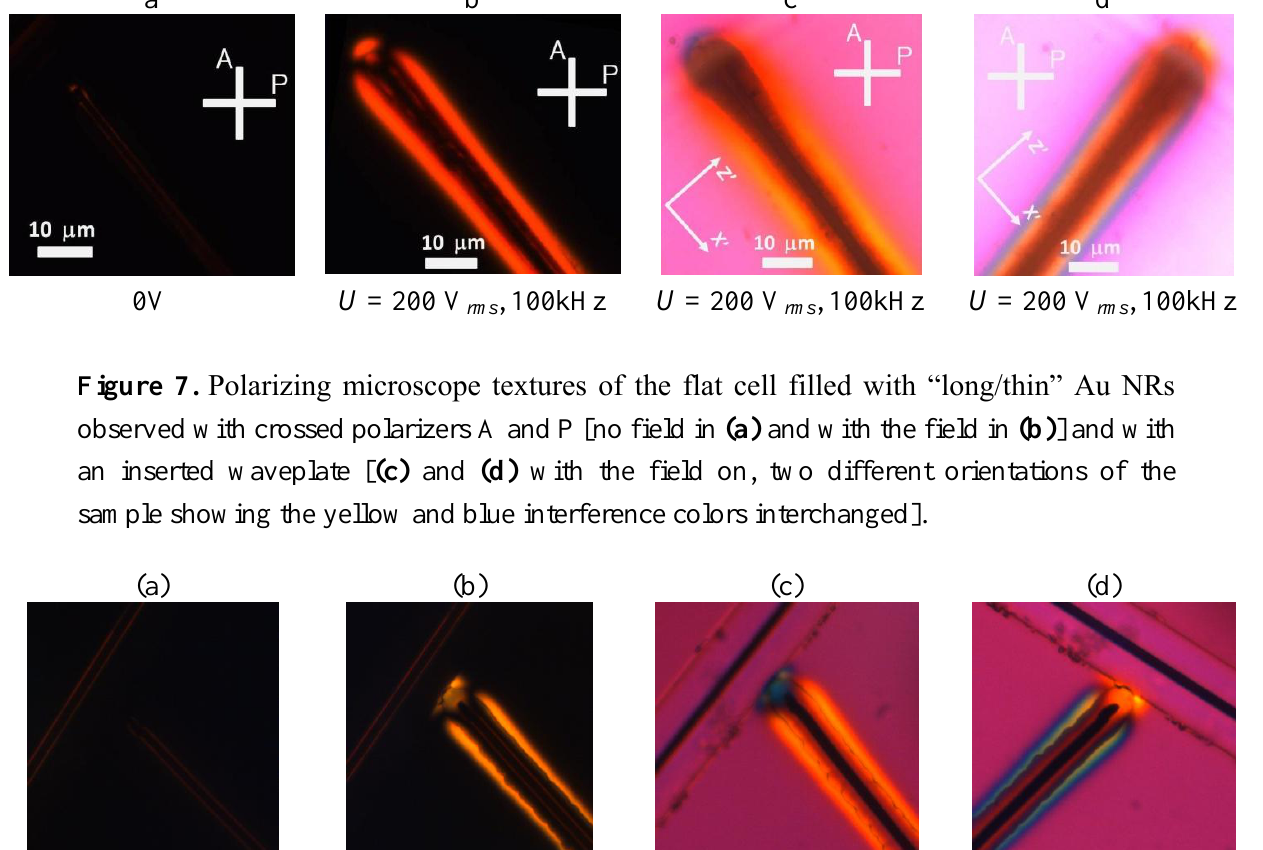
, f = 100 kHz), a rms